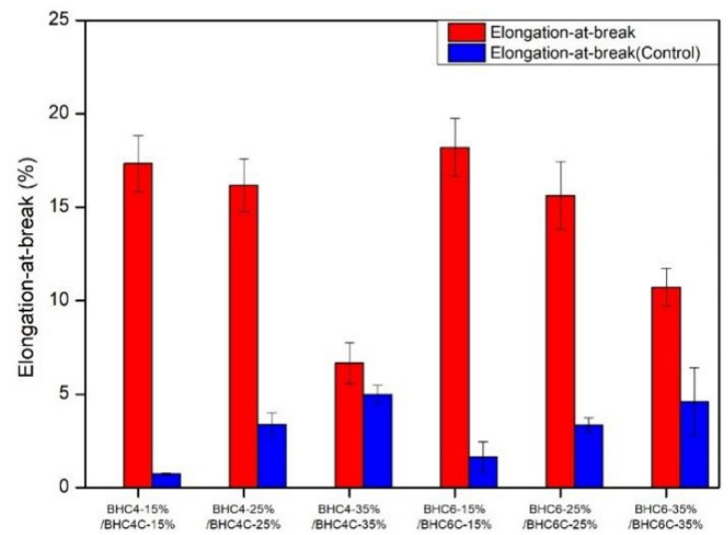
Figure 7. Elongation-at-break of samples from the experimental group and the control group. The experimental group refers to the formulation in Table 1; The control group refers to the formulation in Table 2.